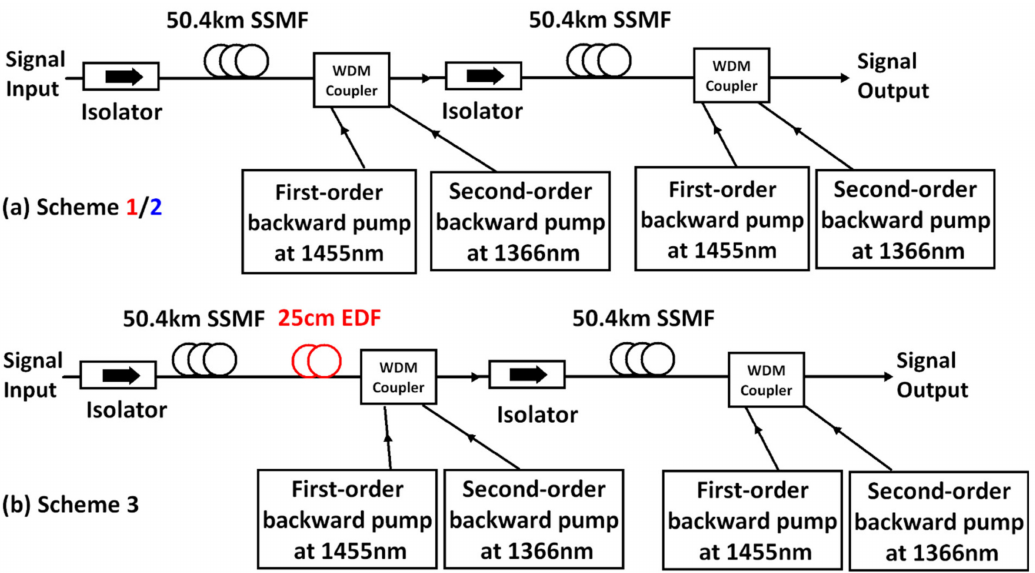
Figure 12. ( a ) Schemes 1 and 2: Dual-order BW-propagated pumping DRA over 2 × 50.4 km SSMF (including two pump power settings). ( b ) Scheme 3: EDF-assisted dual-order BW-propagated pumping DRA over 2 × 50.4 km SSMF.